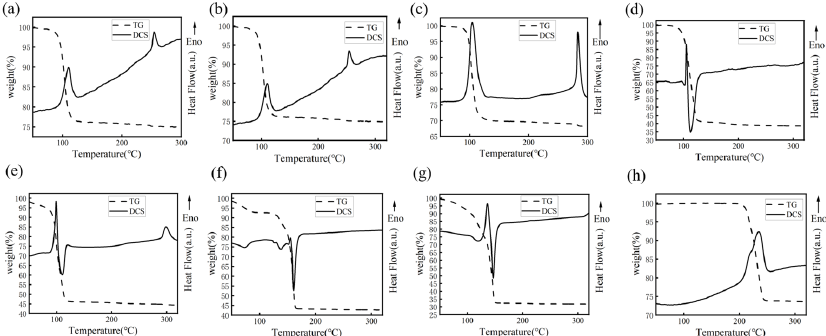
Figure 4. TG-DSC curves of different MOD and silver oxalate (Arrow direction represents endo- thermic reaction): ( a ) MOD1, ( b ) MOD2, ( c ) MOD3, ( d ) MOD4, ( e ) MOD5, ( f ) MOD6, ( g ) MOD7, ( h ) silver oxalate.